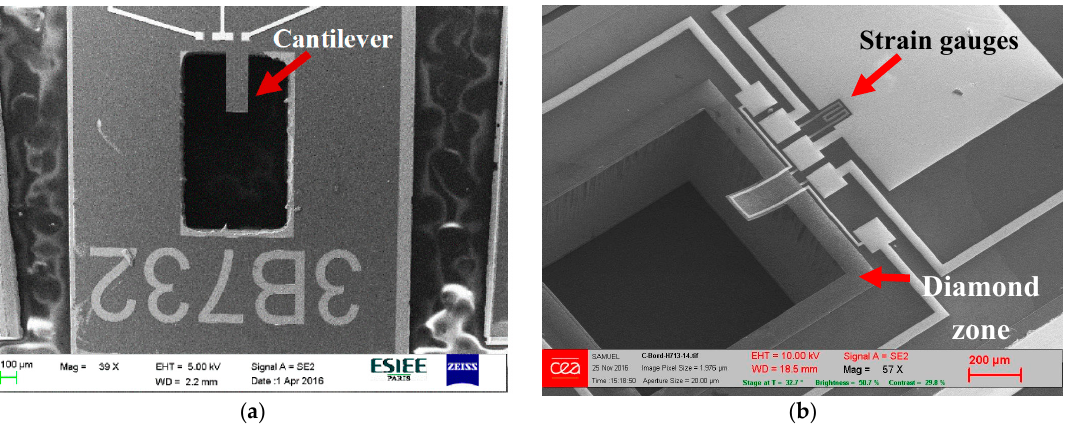
Figure 2. SEM images of polycrystalline diamond micro-cantilevers ( a ) Previous version; ( b ) New